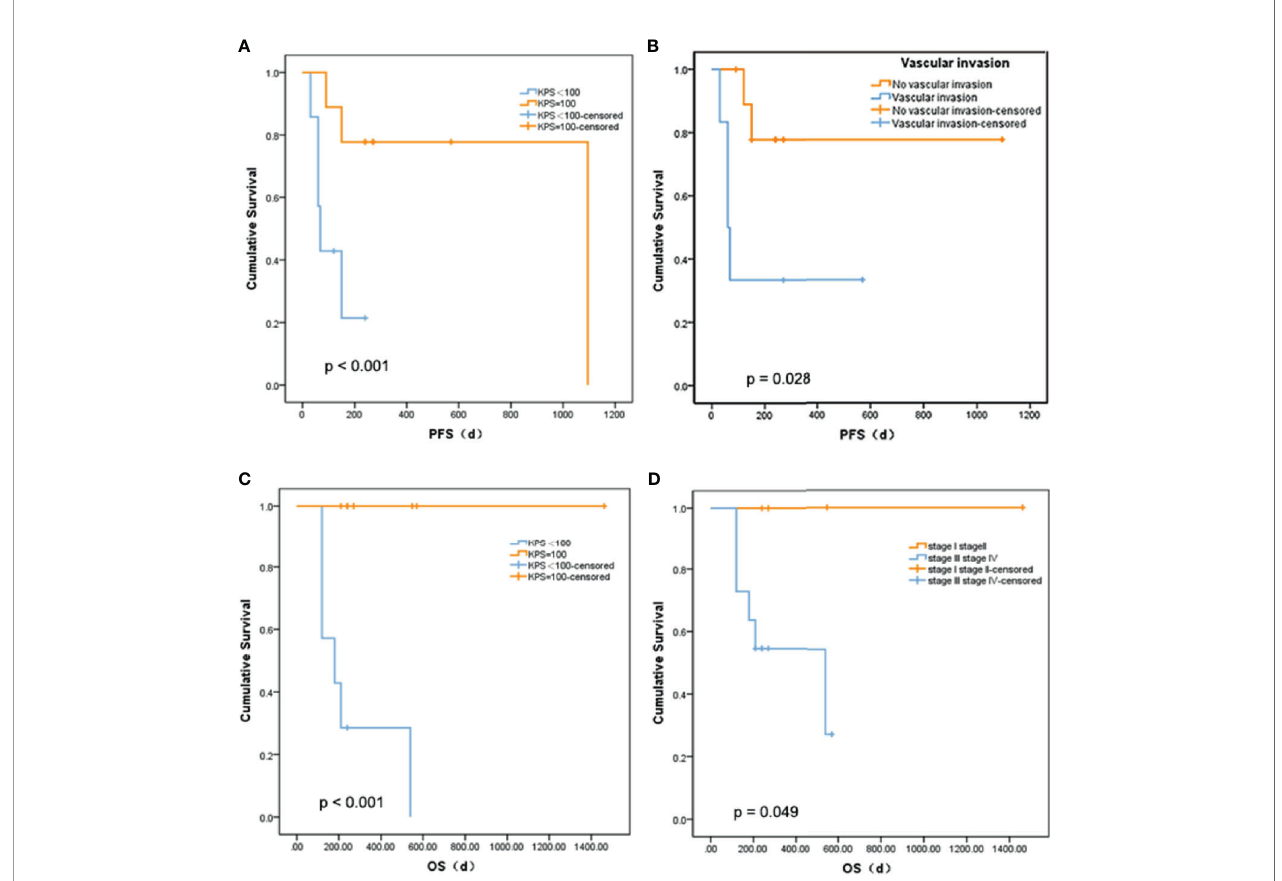
FIGURE 3 | Relationship between survival and clinical indicators. (A) Comparison of PFS between liver cancer patients with different KPS. (B) Comparison of PFS between liver cancer patients with different vascular invasion status. (C) Comparison of OS between liver cancer patients with different KPS. (D) Comparison of OS between liver cancer patients with different tumor